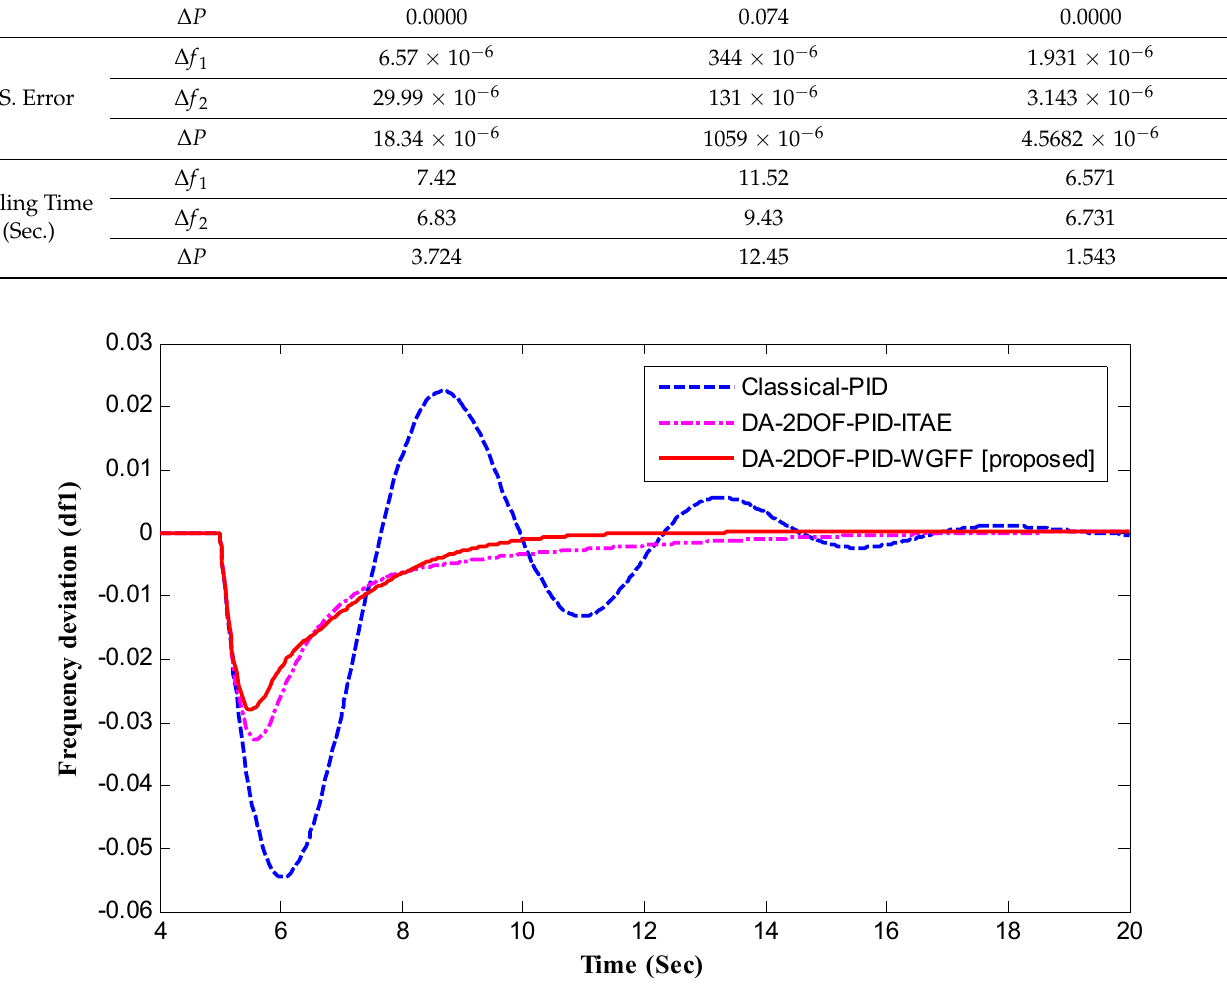
Figure 15. ∆ f 1 using the proposed 2DOF-PID controller compared with other Figure 15. 𝜟𝒇 𝟏 using the proposed 2DOF-PID controller compared with other controllers.